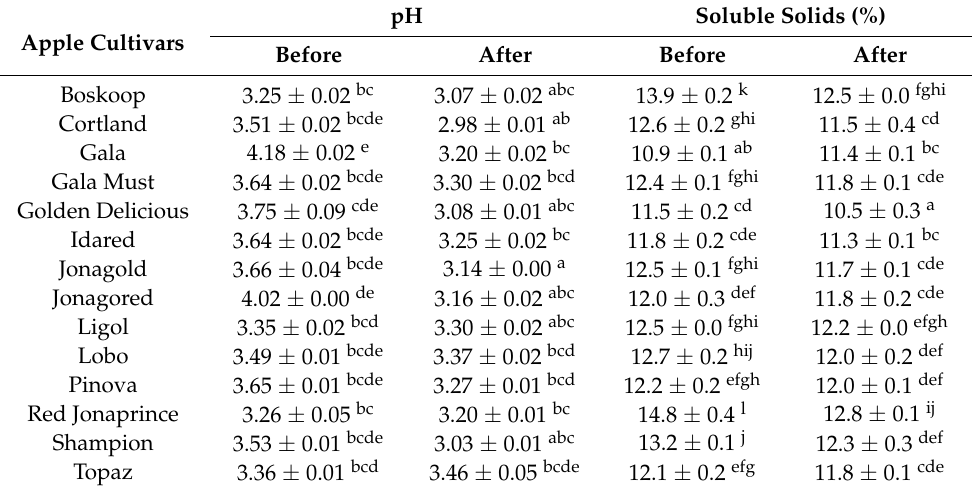
Table 3. pH and total soluble solids of apple cubes before and after VI.